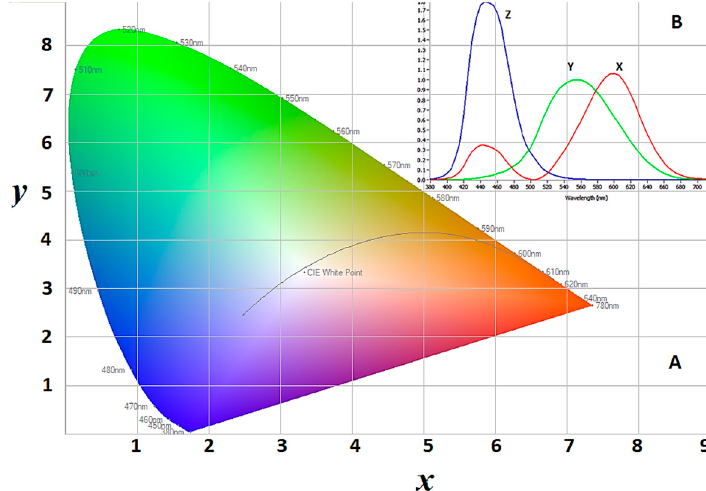
Figure 1. ( A ) The x , y International Commission on Illumination (CIE) chromaticity index. ( B ) The CIE XYZ colour function diagram where the curves are the CIE standard colour matching functions, the values for x and y are obtained from the spectral plot of the emitting light, by calculating integral of the peaks X , Y , and Z and applying Equations (8) and (9). These peaks represent the emission wavelengths from the light source at the specific wavelengths, for example, Z , represents the area under emission peak from 380 to 550 nm.